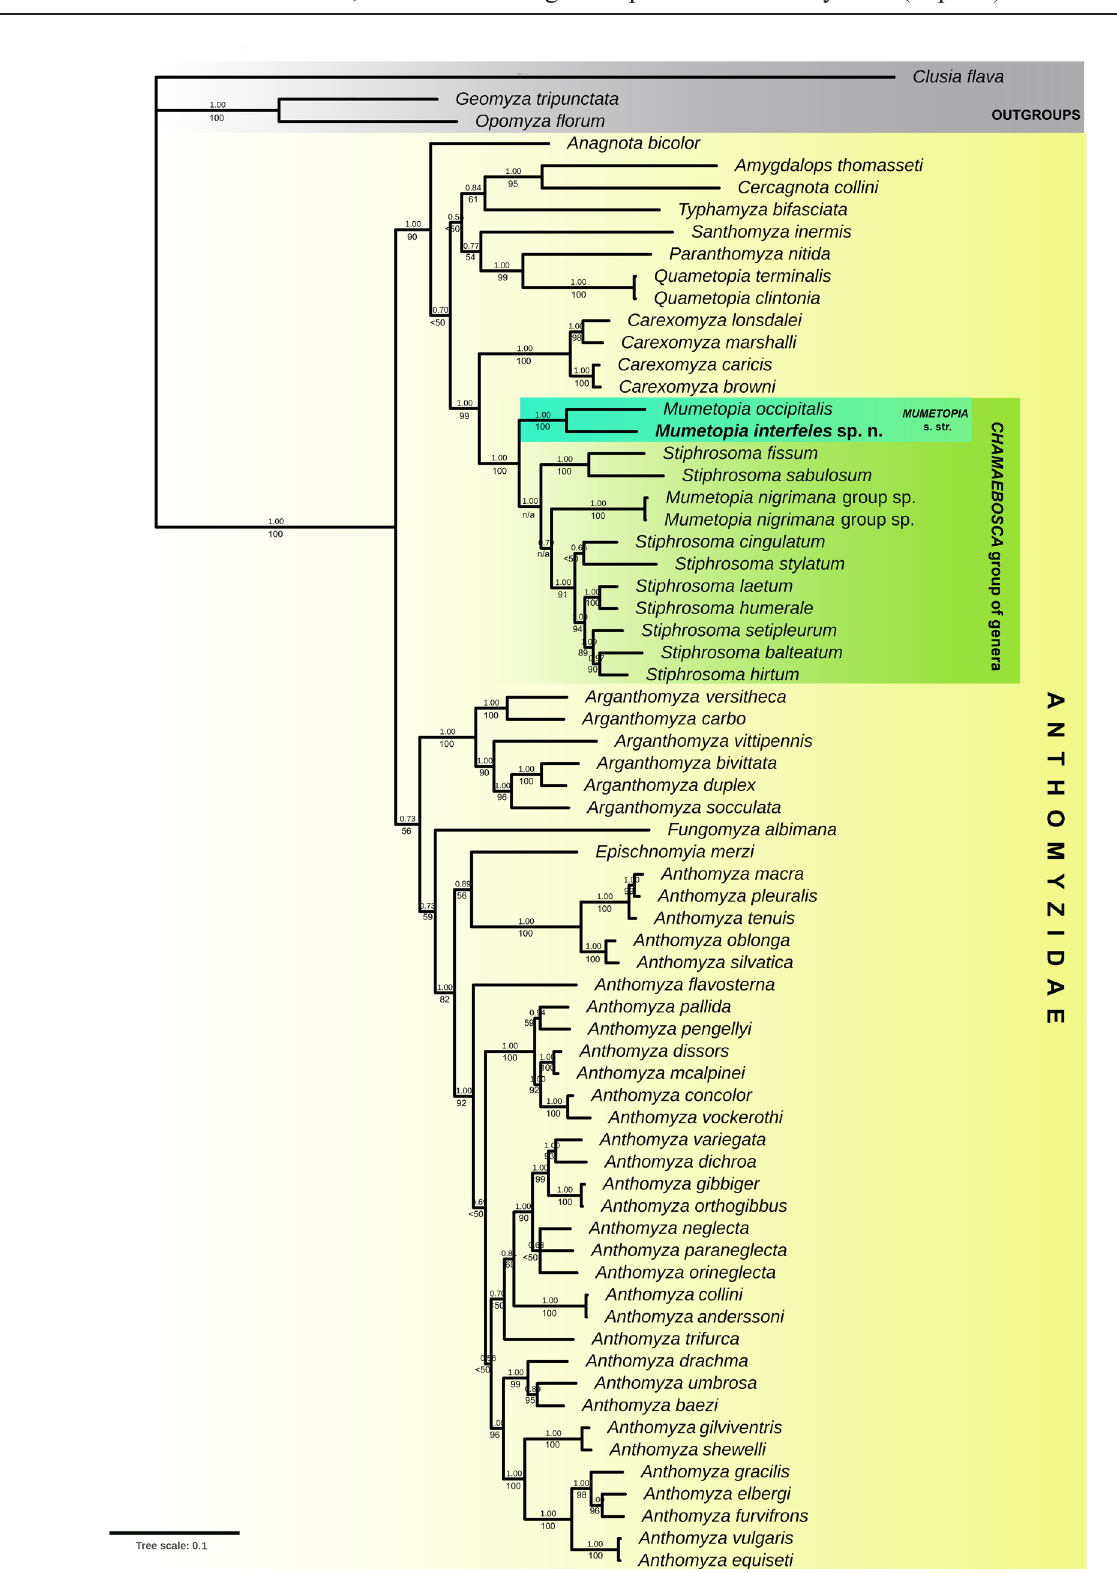
Fig. 32. Bayesian hypothesis for relationships of 64 species of Anthomyzidae based on DNA sequence data (12S, 16S, 28S, COI, COII, CytB, ITS2) representing 4583 characters. Numbers above nodes = posterior probability values if > 0.5, and below nodes = bootstrap support values for